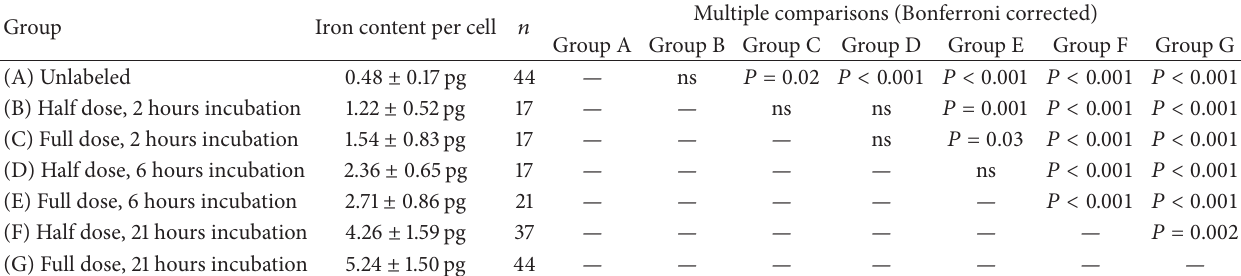
Table 2: Cellular iron content.